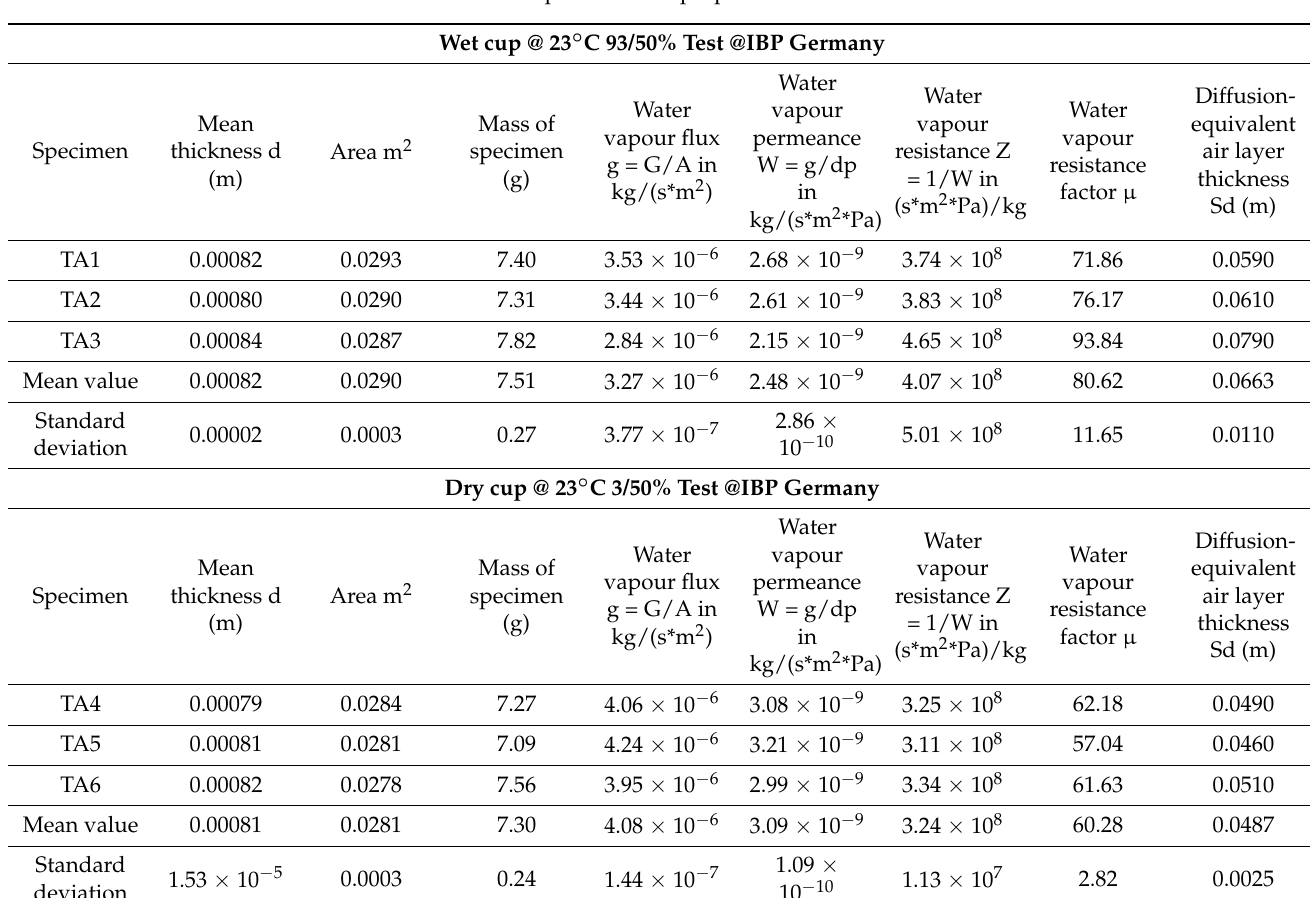
Figure 20. Shelving in the interior of test room at UTAS, Australia. Table 3. Water vapor diffusion properties measured at IBP. Regular weighing measurements of the test dishes were taken every two hours until equilibrium was achieved. The measurements were in milligrams and all weighing data were recorded. The calculations of the water vapor resistivity properties were obtained mathematically (see Tables 3 and 4). Microsoft Excel 365 was used to complete a statistical analysis of variance to establish if there was any significant difference between the result obtained from the laboratory at Fraunhofer IBP and UTAS.